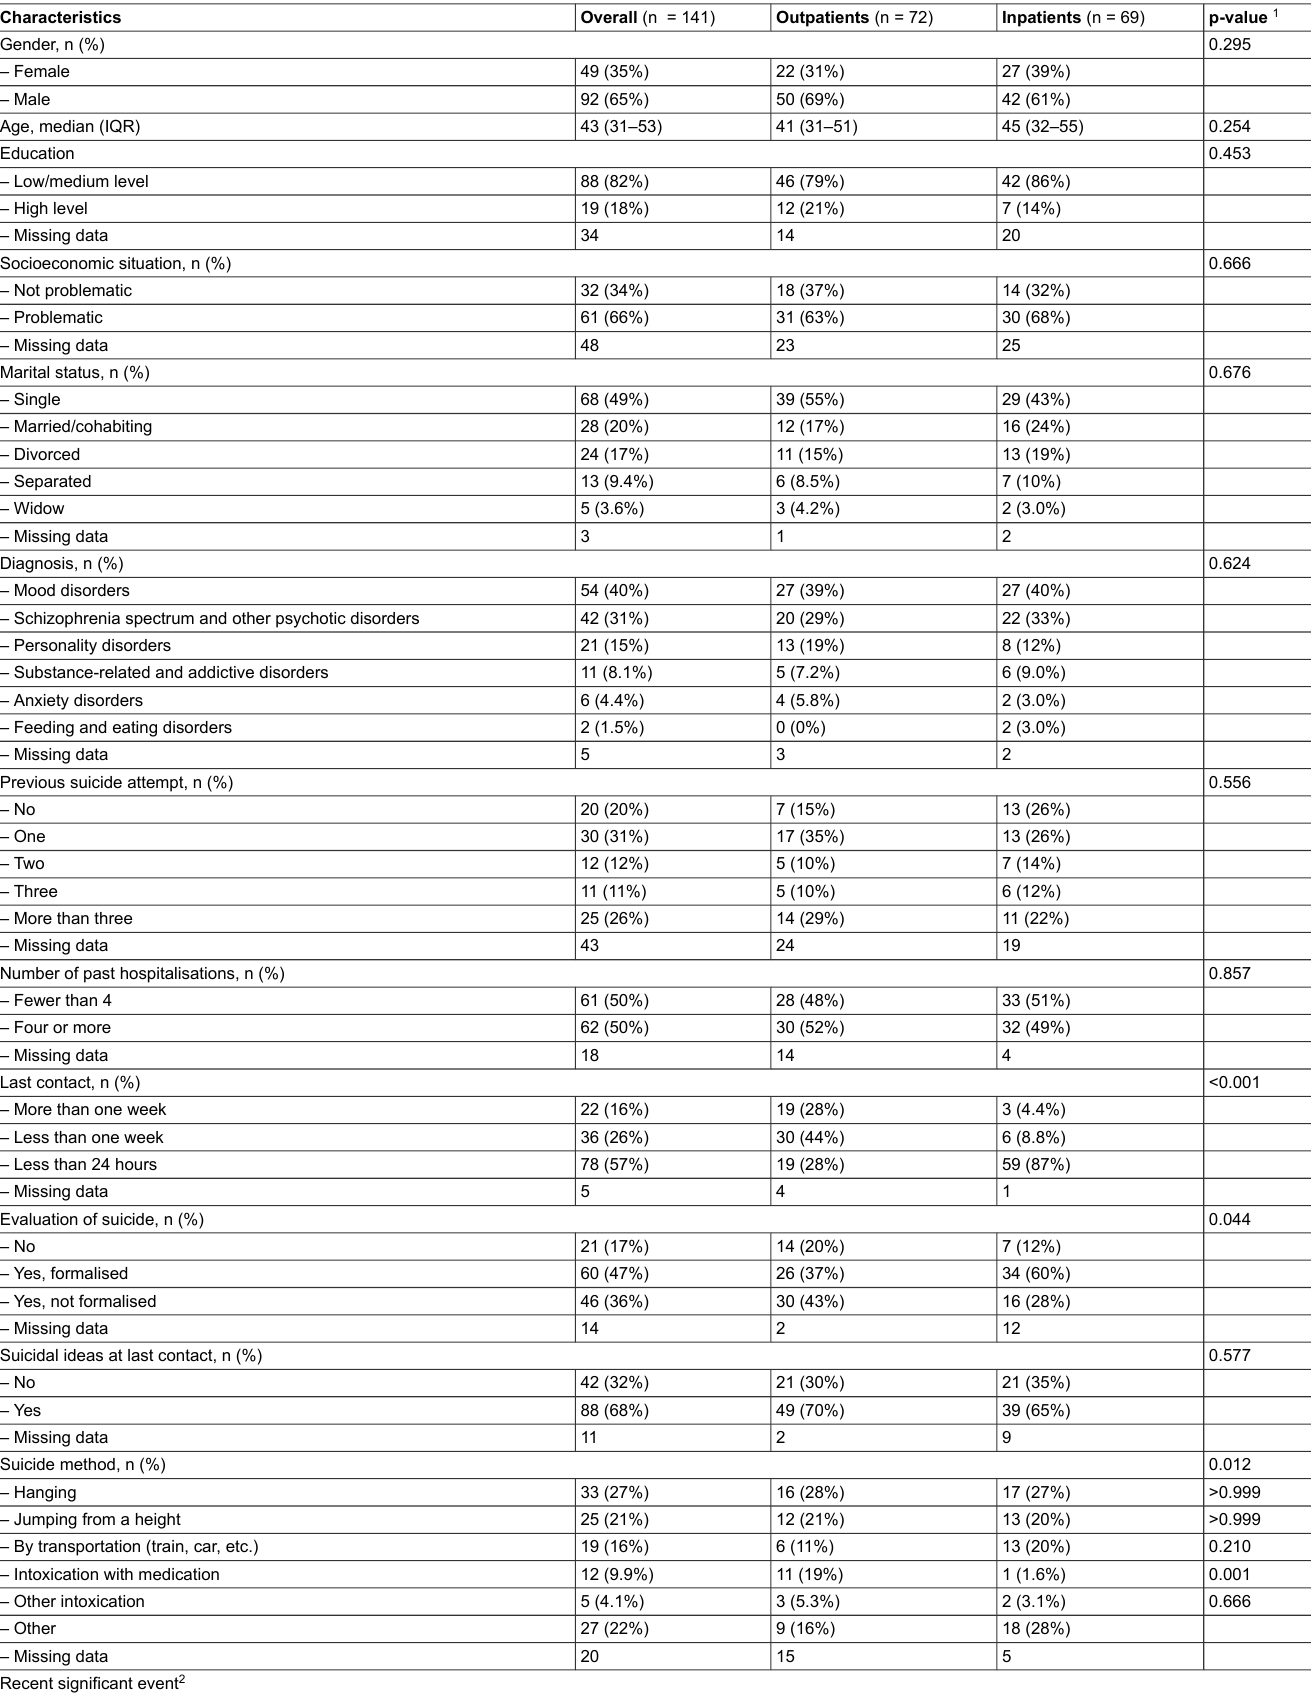
Table 2: Comparison between in- and outpatients.